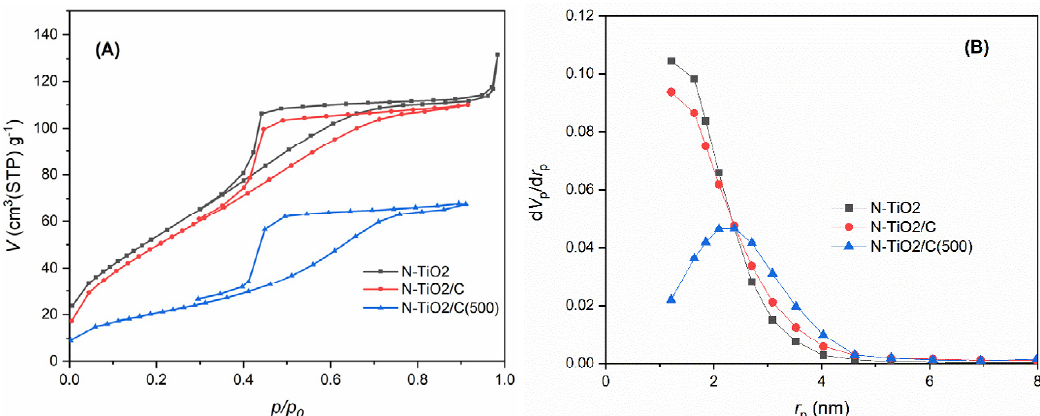
Fig. 1. (A) Nitrogen adsorption-desorption isotherm and (B) BJH plots of N-TiO 2 , N‐TiO 2 /C and N‐TiO 2 /C(500) photocatalysts